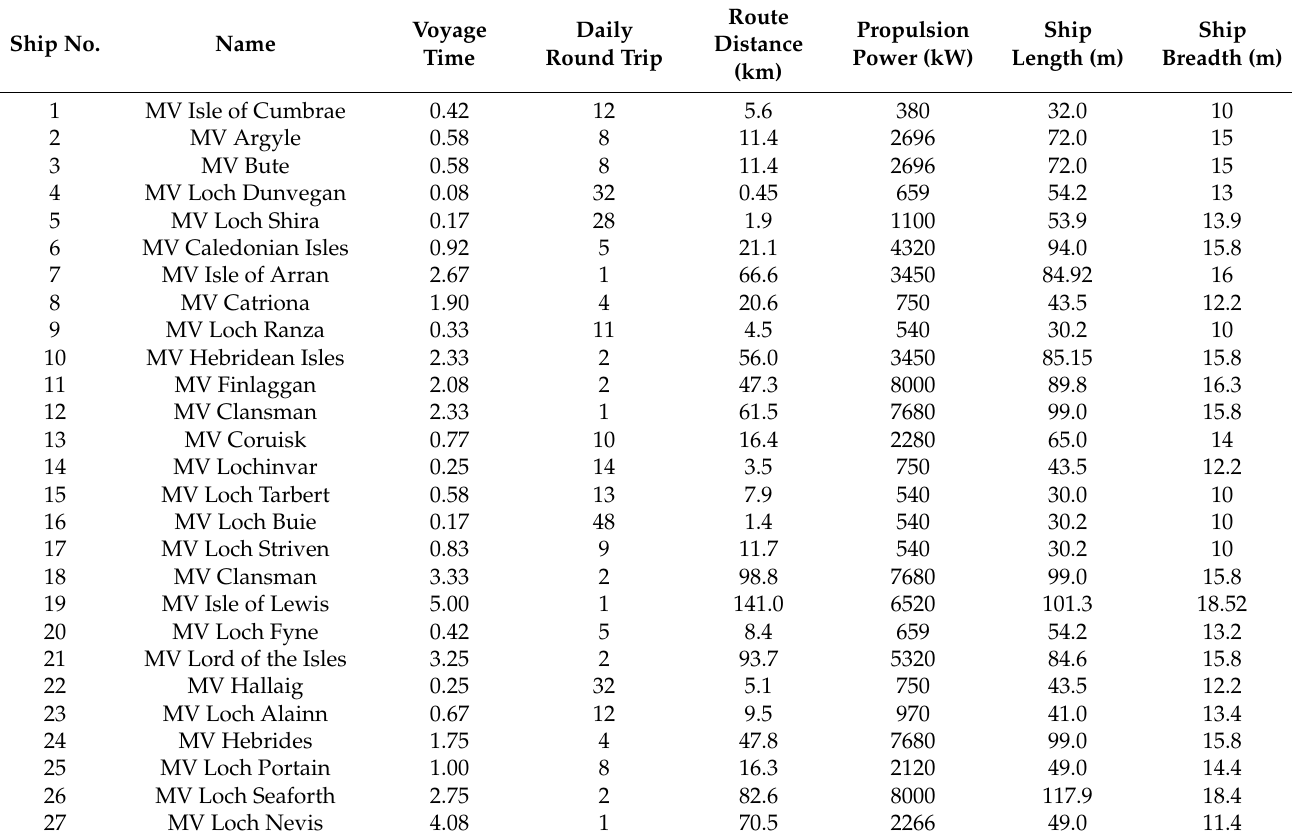
Table 4. Detailed ship specifications and